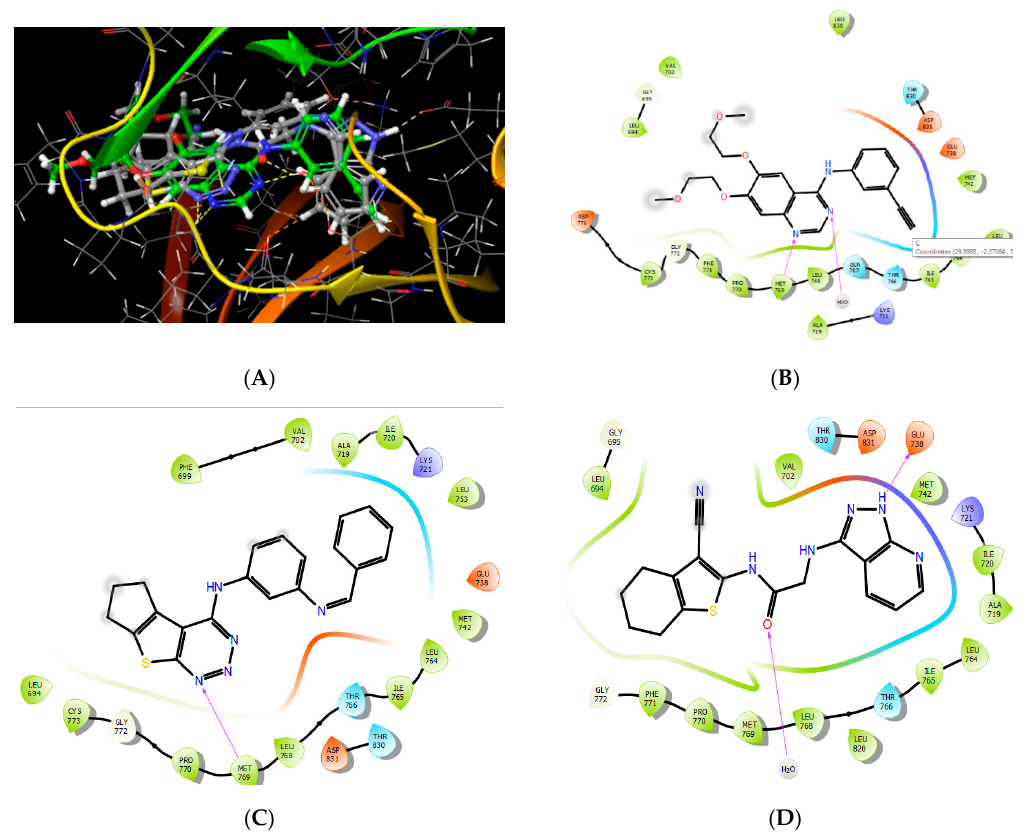
Figure 4. ( A ) Three-dimensional binding modes and overlay of erlotinib ( 3 ), compound ( 14a ), and compound ( 21a ) in the catalytic domain of EGFR (PDB 1M17). ( B ) 2D representation of erlotinib ( 3 ) in the EGFR catalytic domain. ( C ) 2D representation of compound ( 14a ) in the EGFR catalytic domain. ( D ) 2D representation of compound ( 21a ) in the EGFR catalytic domain.